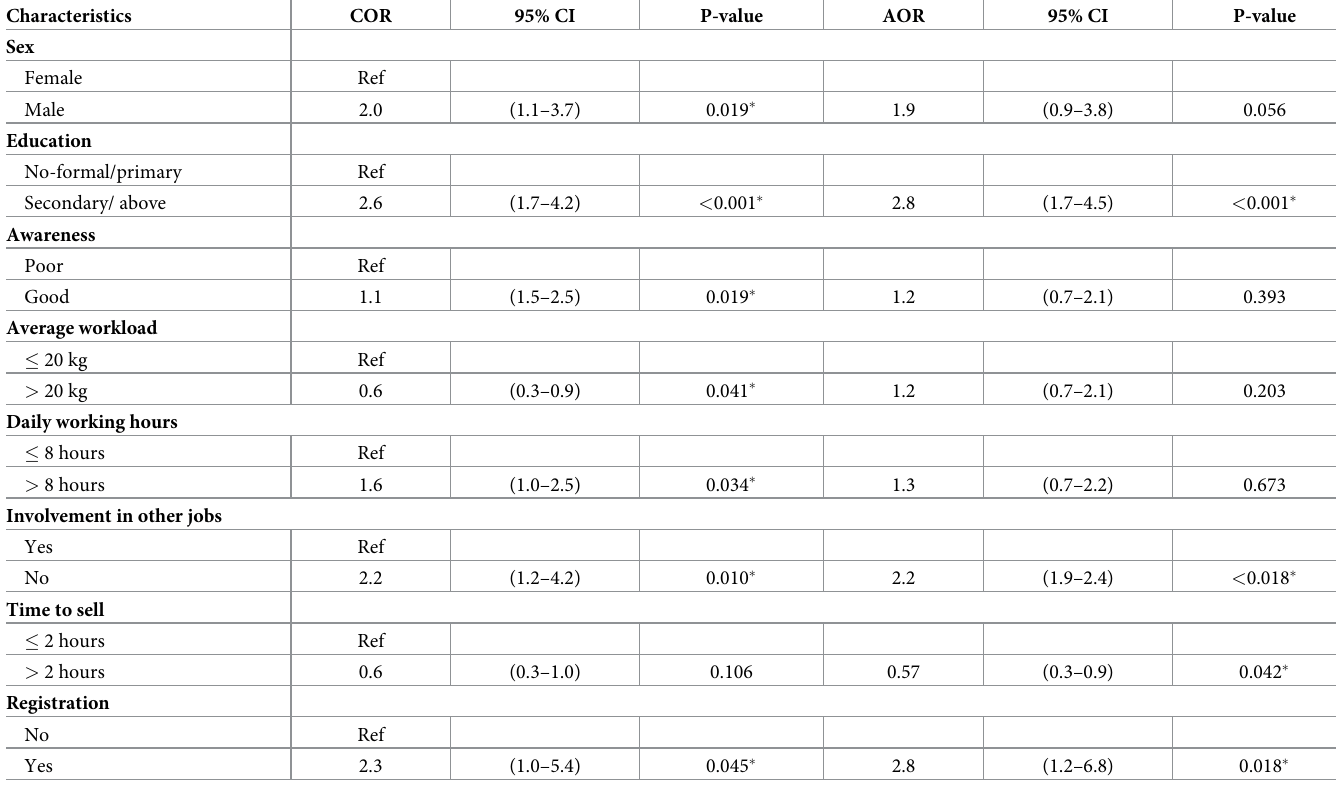
Table 4. Multivariate analysis of independent variables with level of meat hygiene practice.